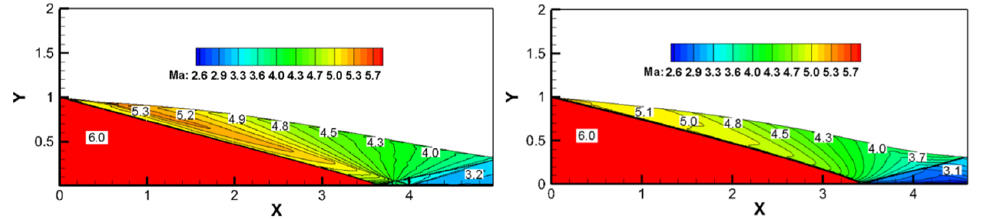
Figure 8. Improvement of the high ‐ external ‐ ratio basic flow field: ICFC (left) and ICFC+ (right). The configuration of the new spillage-adaptive bump inlet is shown in Figure